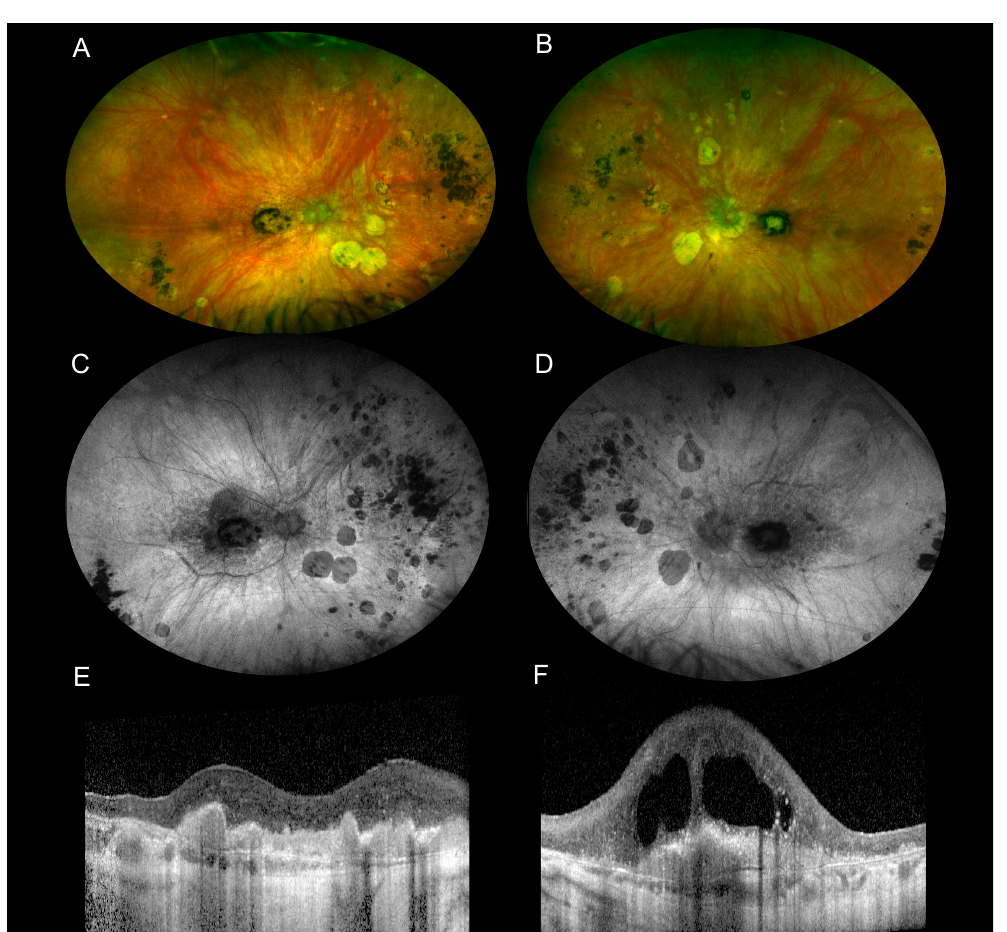
Figure 2. Multimodal imaging of a 91-year-old woman with long-lasting BSCR complicated with macular neovascularization. The BSCR was diagnosed 30 years ago. ( A , B ) Wide-field color fundus photography showed birdshot lesions with chorioretinal atrophy predominantly nasally from the optic disc. Pigmented changes are seen at the level of birdshot lesions and at the macula. ( C , D ) Wide-field fundus autofluorescence shows confluent hypoautofluorescence of the birdshot lesions due to RPE atrophy of the macula and around the optic disc in both eyes. ( E , F ) OCT B scans identify hyperreflective fusiform lesions at the level of the macula in both eyes, consistent with a fibrovascular scar. There is no subretinal or intraretinal fluid in the right eye, whereas there is degenerative macular edema in the left eye. The choroid is very thin in both eyes.